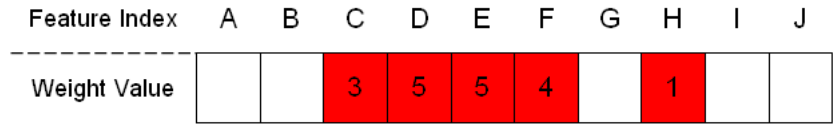
Table 3. The weight values and ranking of selected features of Figure 6.